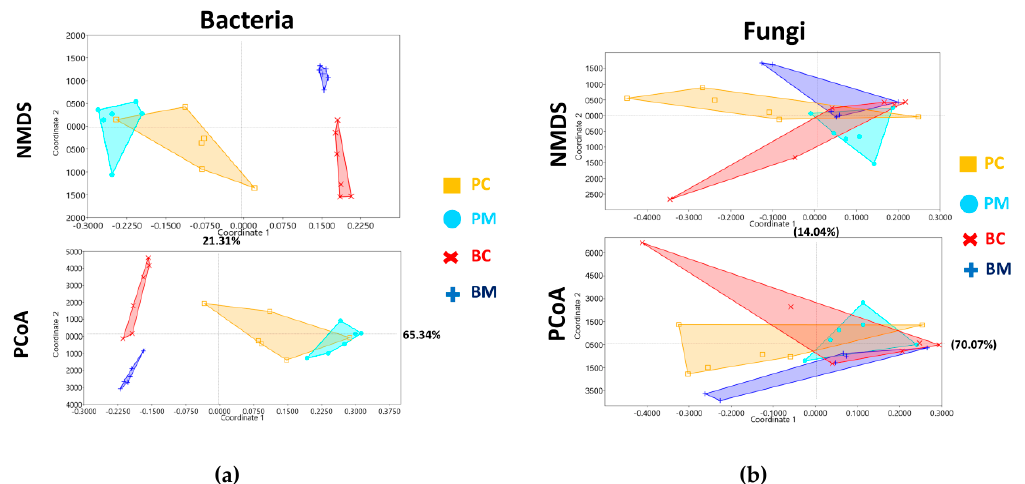
Figure 3. Four ordination plots from non-metric multidimensional scaling (NMDS) and principal correspondence analysis (PCoA) analysis, showing the distance between the investigated groups of bacterial ( a ) and fungal ( b ) community